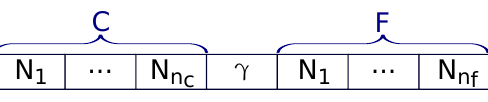
Figure 5. BloCop content.